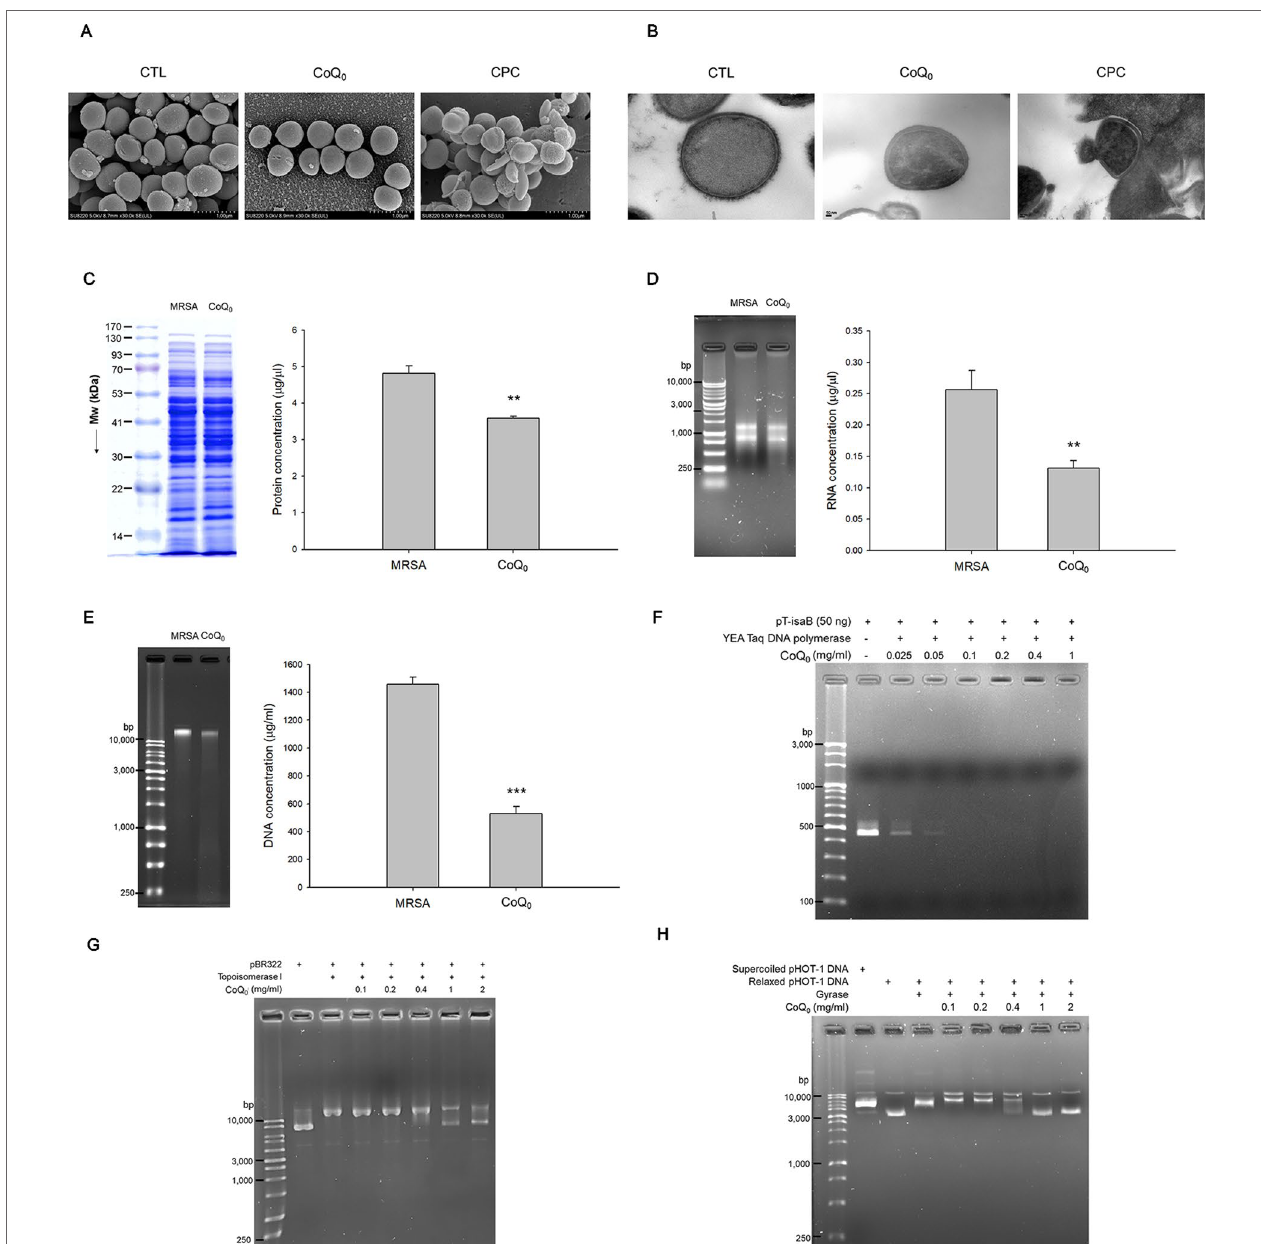
FIgURE 3 | Anti-MRSA mechanisms of CoQ 0 . (A) Morphological changes of MRSA viewed under SEM. (B) Morphological changes of MRSA viewed under TEM. (C) Total protein amount in MRSA. (D) Total RNA amount in MRSA. (E) Total DNA amount in MRSA. (F) Taq DNA polymerase in PCR. (g) Topoisomerase I in wrapping assay; (h) DNA gyrase in wrapping assay. Each value represents the mean ± SEM (n = 4). *** p < 0.001; ** p < 0.01.